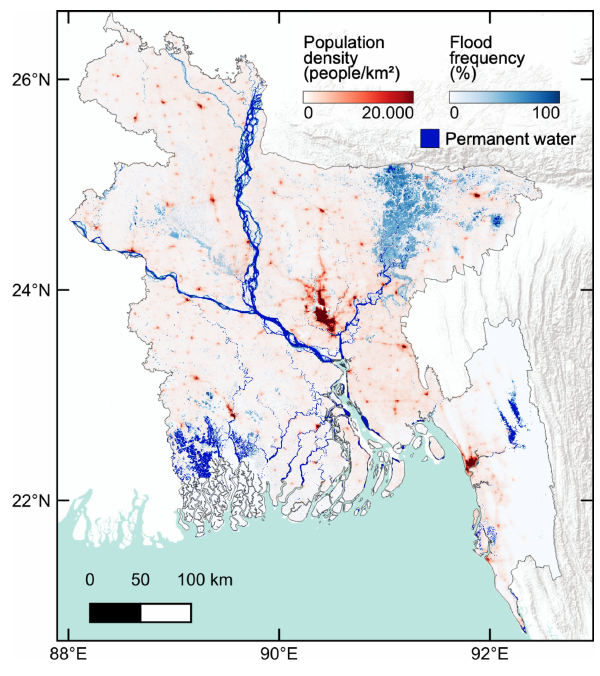
Figure 6. Flood frequency map of Bangladesh between January 2017 and December 2021. Population data from Tatem (2017), permanent water from Buchhorn et al.